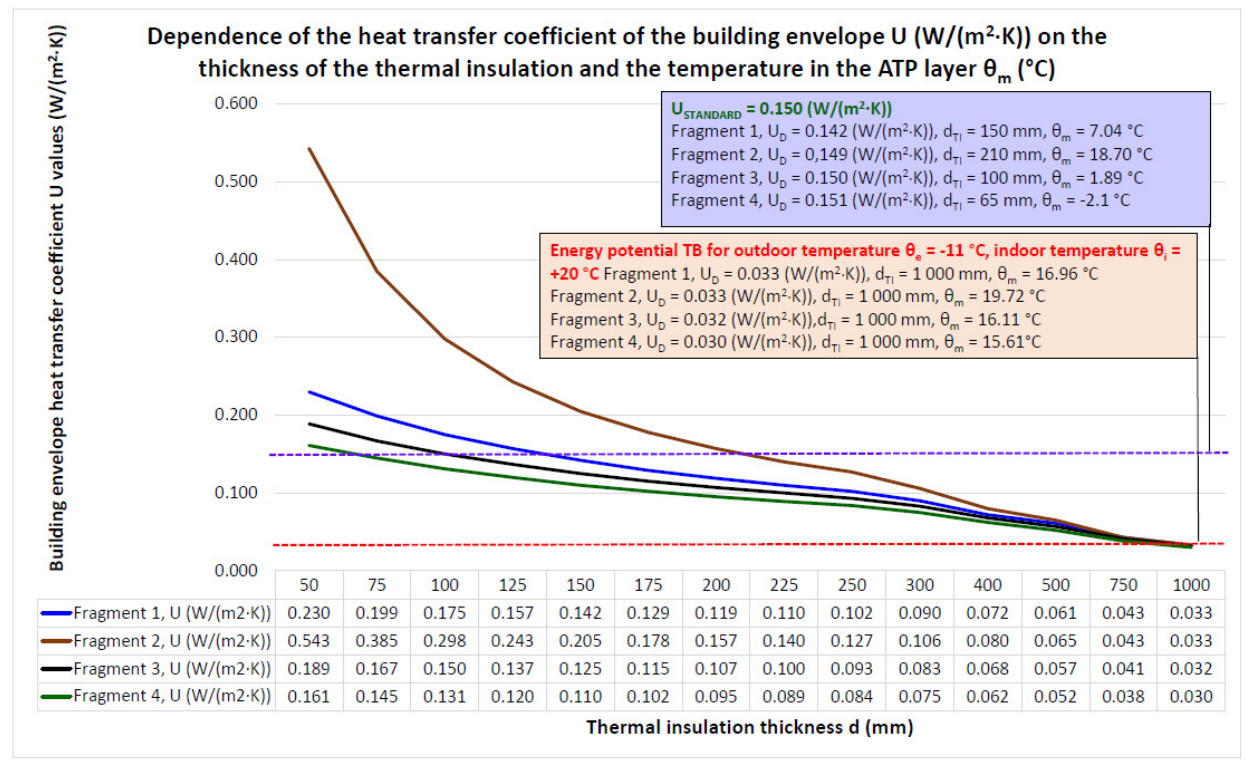
Figure 39. The graphical dependencies of the dynamic thermal resistance R DTR ((m 2 ·K)/W) on the thickness of the static/dynamic thermal insulation and the mean temperature of the heat transfer medium in the ATP tubes θ m (°C) for all fragments investigated.